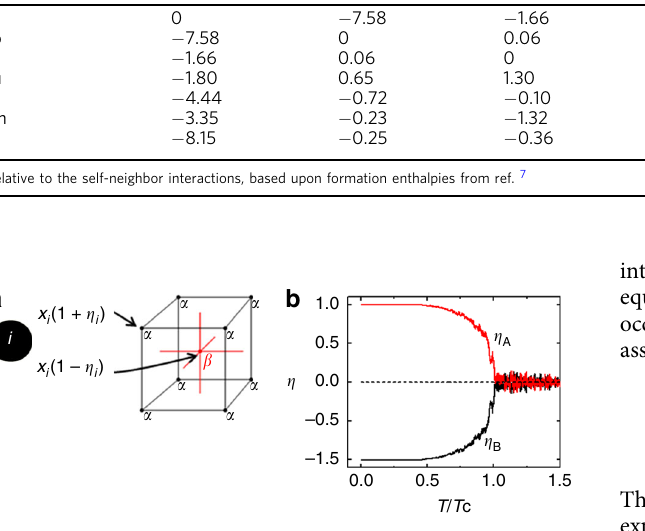
Fig. 2 Con fi gurational order parameters. a An illustration shows how multiple elements, each with a mole fraction, x i , fi ll the interpenetrating lattices, α and β , according to a set of order parameters, η i . b In the case of a binary alloy, there is only one independent order parameter, η = η A = − η B , which is normally plotted over a range of 0 to 1, and as a function of the reduced temperature, T / T c , where T c is the ordering temperature. Here both η A and η B , are plotted, over the range of – 1 to 1, as will be necessary for HEAs with four or more principal elements. The plots contain